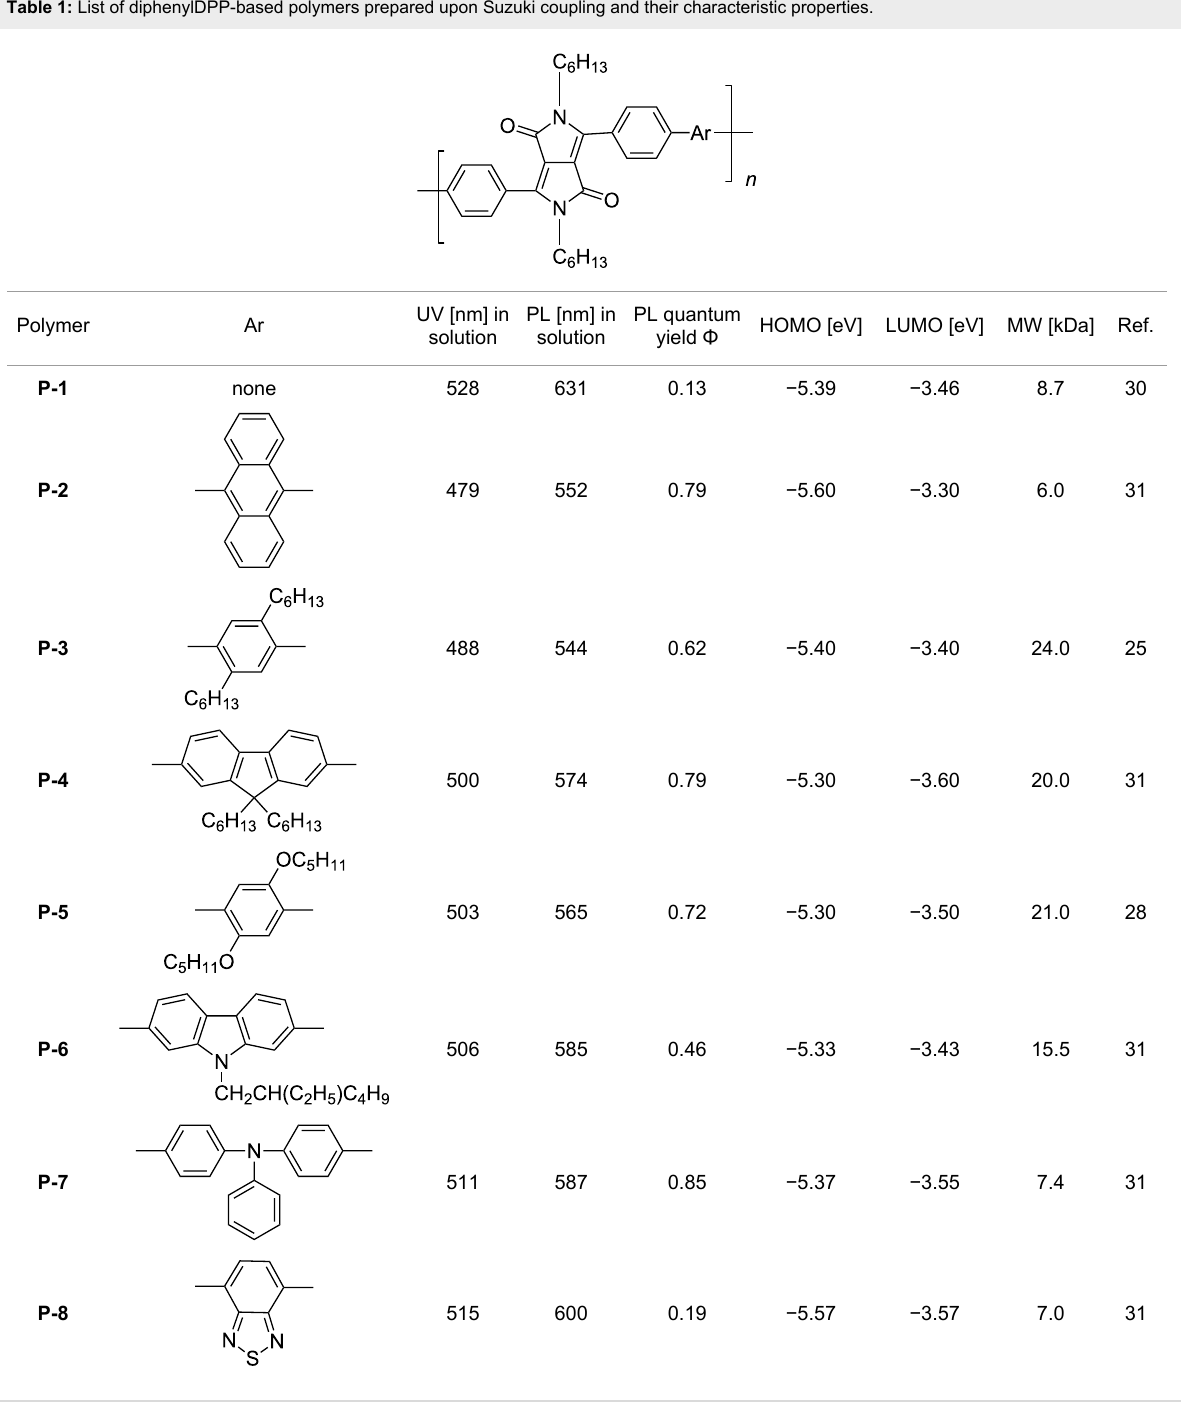
Table 1: List of diphenylDPP-based polymers prepared upon Suzuki coupling and their characteristic properties.